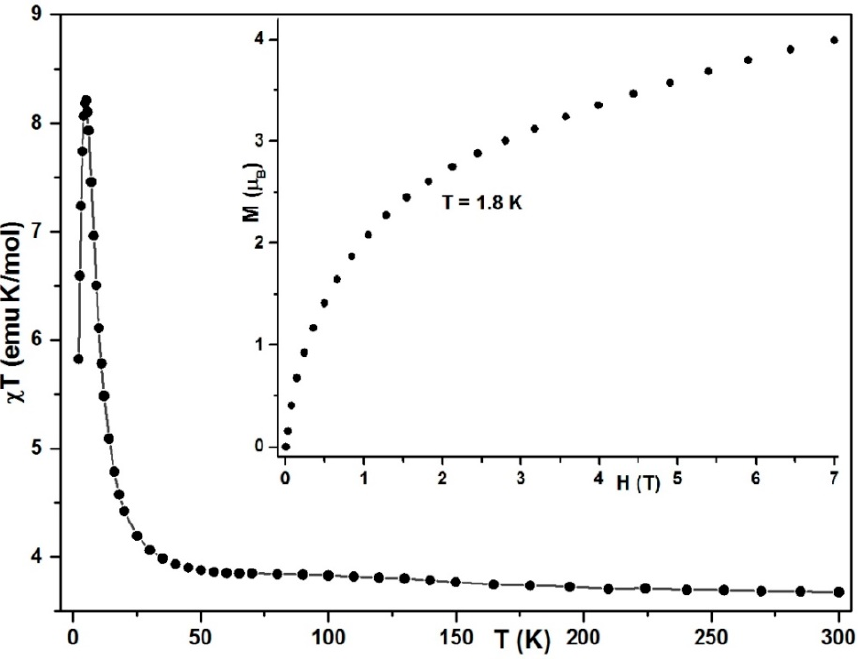
Figure 15. Magnetic dc plots for 13 . Temperature dependence of χ T at H = 1000 Oe (solid line). Inset: magnetization versus the field at T = 2 K [46].